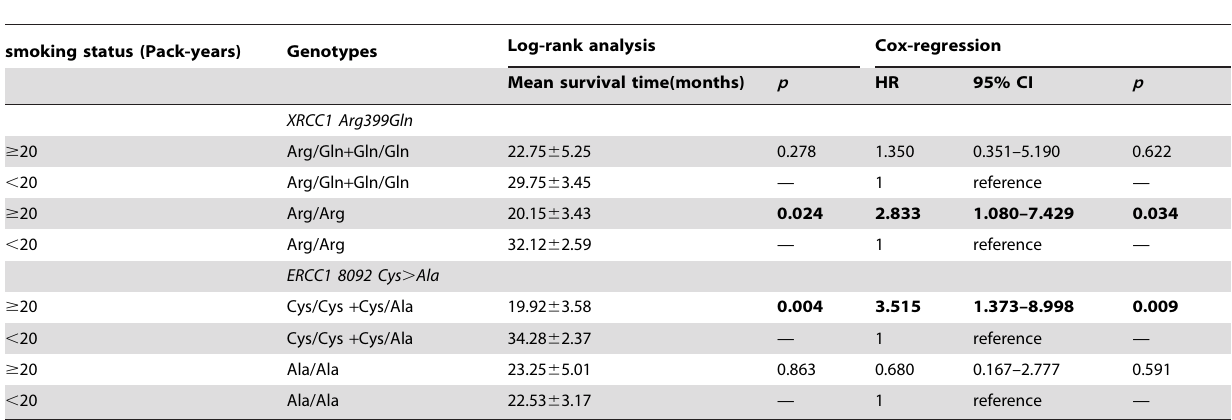
Table 2. Log-rank and proportional hazard analysis (Cox method) for progression-free survival (PFS) related to smoking